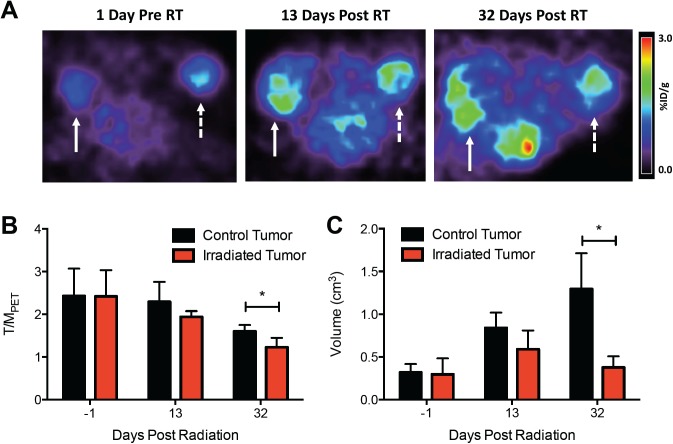
Effect of radiation on tumor 18F-EF5 uptake.(A) Representative axial 18F-EF5 PET images of two tumors at 1 day pre-treatment and 13 / 32 days post-treatment. Solid arrow denotes unirradiated control tumor, and dashed arrow denotes tumor which was treated with 20 Gy. (B,C) Plots showing changes in 18F-EF5 uptake and volume, respectively, in control (n = 6) and irradiated (n = 6) tumors during the treatment timecourse.